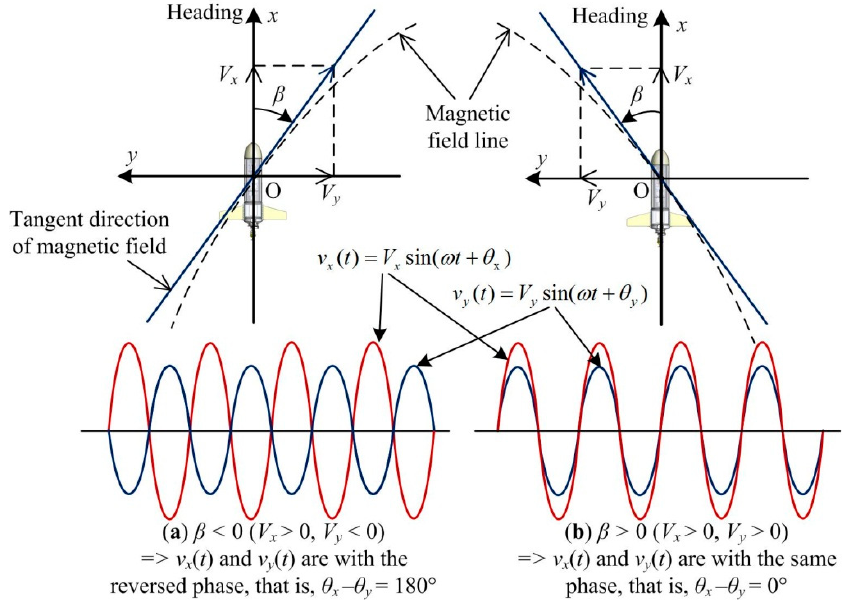
Figure 12. Scenarios when deflection angle in horizontal plane β < 0 and β > 0. ( a ) β < 0 ; ( b ) β > 0.